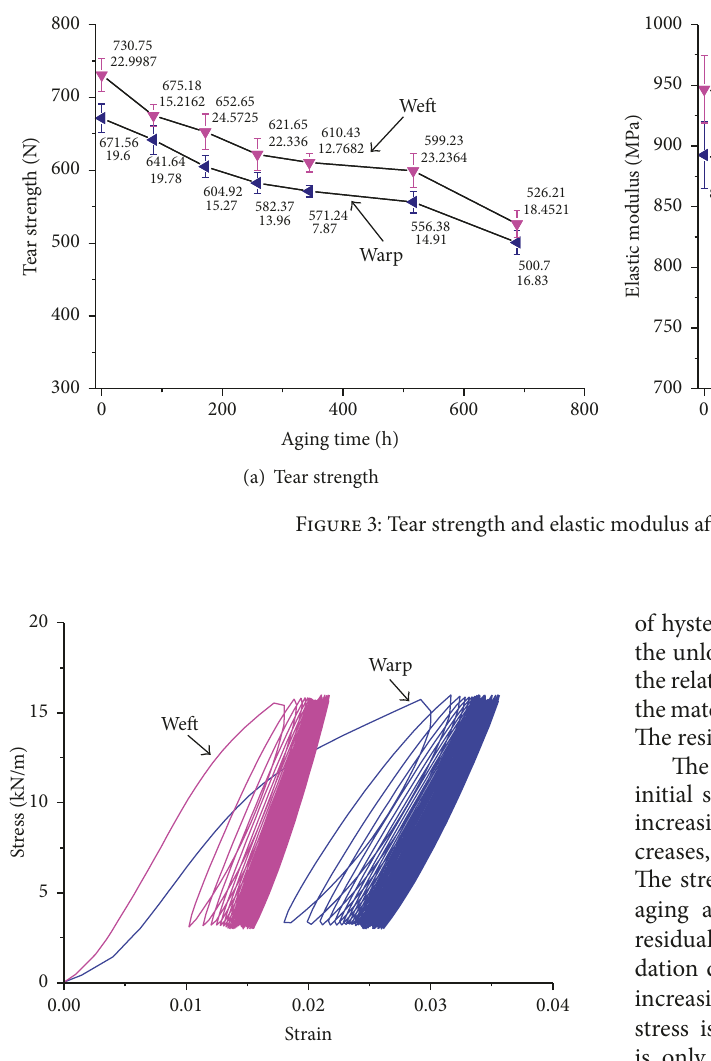
Figure 4: Cyclic tensile curves with the stress amplitude of 3–16